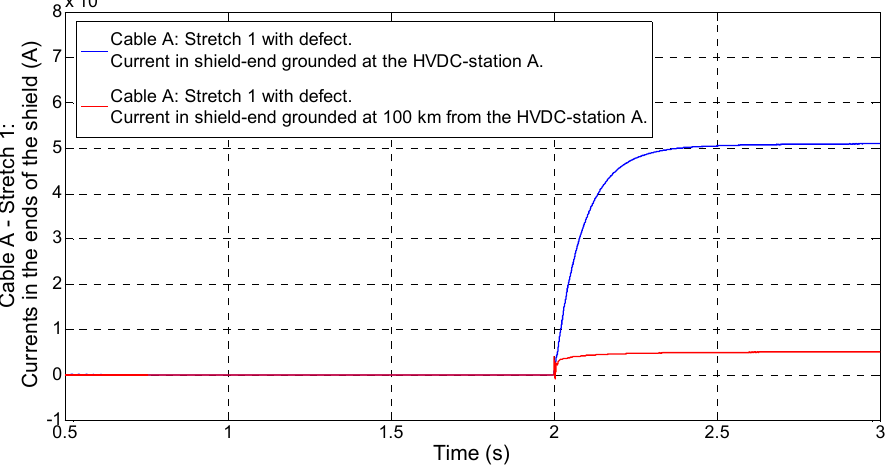
Figure 10. Circulation of ground fault currents in the ends of the shield in Stretch 1 of Cable A in case of internal ground fault.